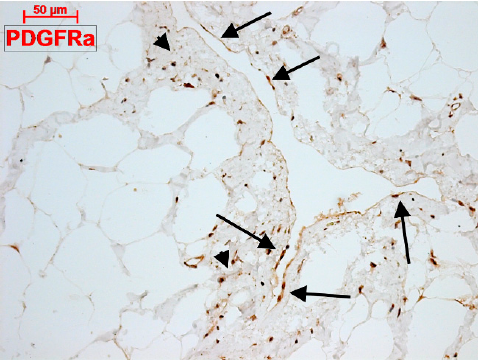
Figure 4. Human adult cardiac wall. Epicardial (mesothelial) (arrows) and subepicardial (arrowheads) expression of Platelet-Derived Growth Factor Receptor (PDGFR α ).